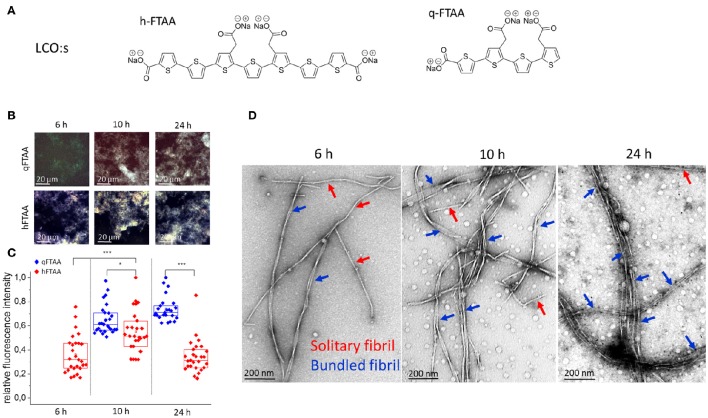
(A) Chemical structure of the in-house synthesized LCOs used. (B–D) Samples from selected time points during fibrillation were stained with q-FTAA and h-FTAA for hyperspectral imaging as well as prepared for TEM analysis (B) Representative images taken with identical microscope settings within the dynamic range of the detector, using hyperspectral imaging with long pass filter in epifluorescence mode. (C) Relative maximum fluorescence intensities from the entire images. Significance was calculated using two-sample t-test, *p < 0.05, ***p < 0.001. (D) Representative TEM images from selected time points. At 6 h the q-FTAA fluorescence was too weak to give reliable fluorescence data (B, top left and C, data missing). The relative amount of multi-filamentous bundled fibrils as demonstrated by TEM was lower at 6 h as compared to 10 and 24 h. q-FTAA fluorescence increases relative to h-FTAA fluorescence (C) as the presence of fibril bundles becomes more pronounced (D). Spherical globular species likely oligomers were observed at all time-points.